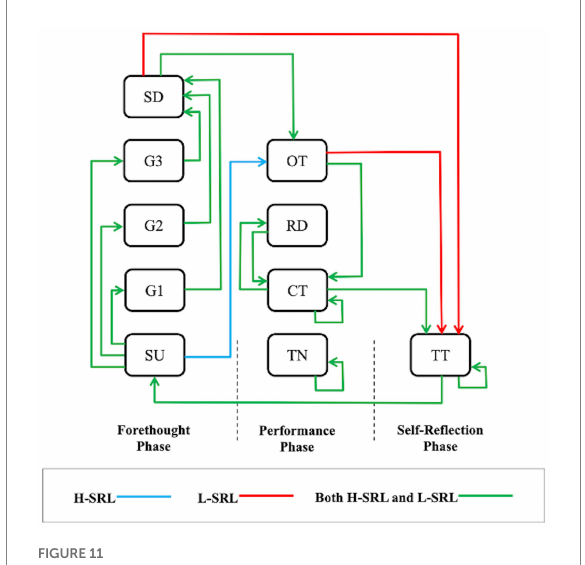
FIGURE 11 Behavior patterns of the H-SRL and L-SRL.